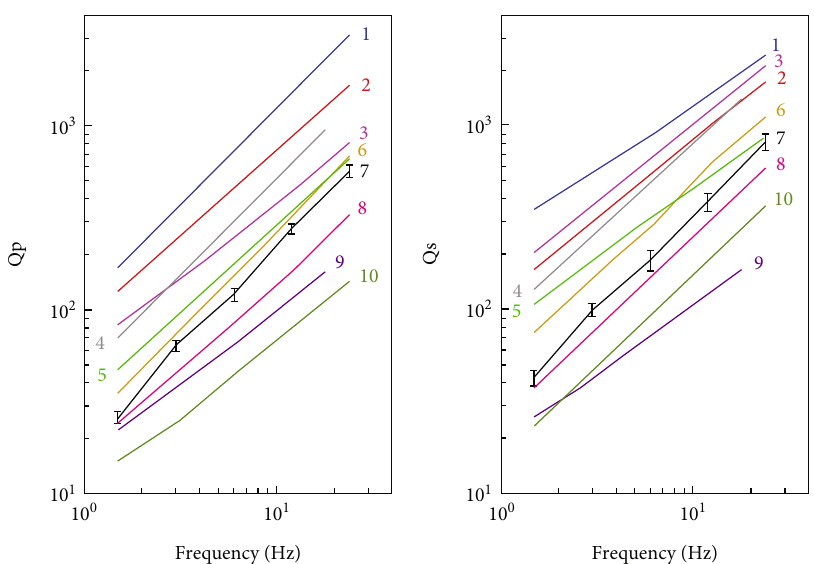
Figure 8: Comparison of Q and Q values for di ff erent regions. Line 1: South Eastern Korea [47]; line 2: Baoshan, China [56]; line 3: Cairo, P S Egypt [55]; line 4: Kinnaur Himalaya [49]; line 5: Kanto, Japan [11]; line 6: Bhuj, India [48]; line 7: this study; line 8: Umbria-Marche, Italy [54]; line 9: Etna, Italy [52, 59]; and line 10: Qeshm Island, Iran